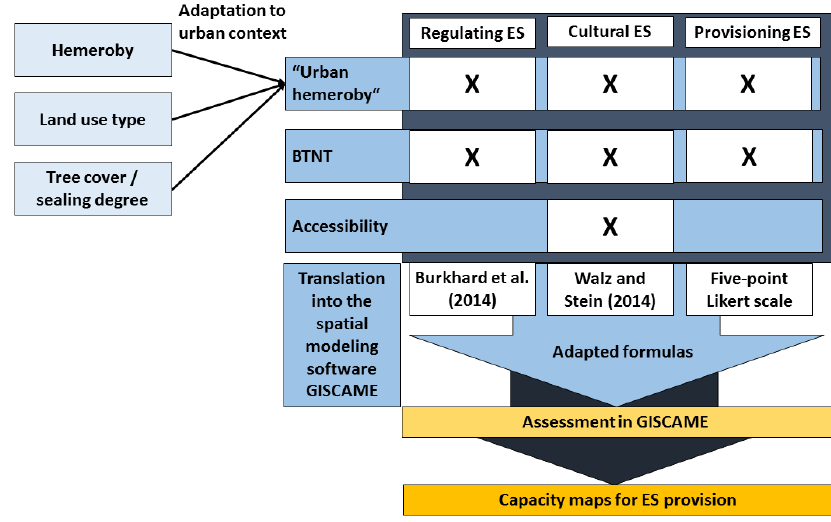
Figure 2. Overview of the methodological framework. A ticked box means that the respective approach was used to assess the ecosystem service (ES). BTNT = Regional biotope and land use data set. GISCAME: GIS = geographic information system, CA = cellular automaton, ME = multi criteria